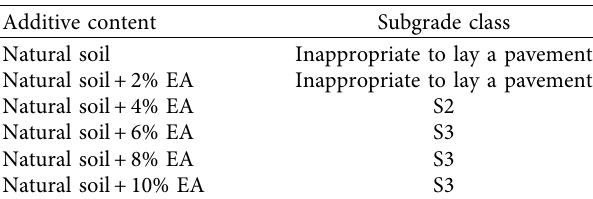
Figure 7: XRD analysis results: (a) percentage of mineral present in the soil, (b) quartz peak, (c) montmorillonite peak, and (d) kaolinite peak, and (e) when natural soil is treated with 10% EA. Table 6: Subgrade class of soil with Enset